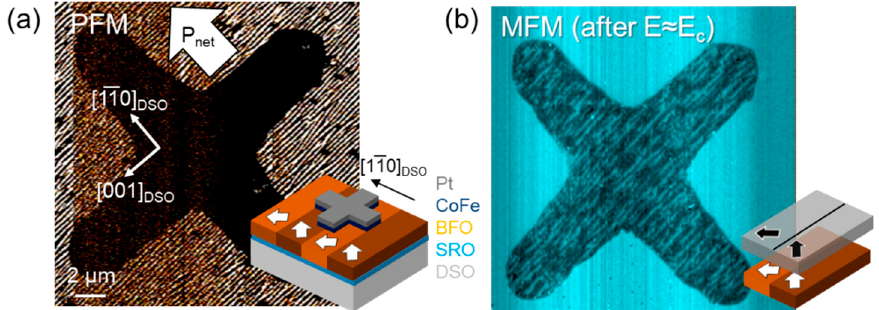
Figure 4. ( a ) Magnetoelectric characterization of the Pt/CoFe/BFO/SRO//DSO heterostructure. The in-plane PFM response reveals an FE stripe-domain distribution in BFO, yielding an in-plane net polarization P net (white arrow). The cross-shaped metallic electrode prevents the observation of the buried FE BFO domain structure. In the inset, the multilayer structure is depicted. ( b ) MFM performed after application of an electric poling field close to the BFO coercive field E c yields magnetic stripes with the same orientation as in the BFO film not covered by CoFe. Reprinted with permission from [93], copyright the American Physical Society, 2018.